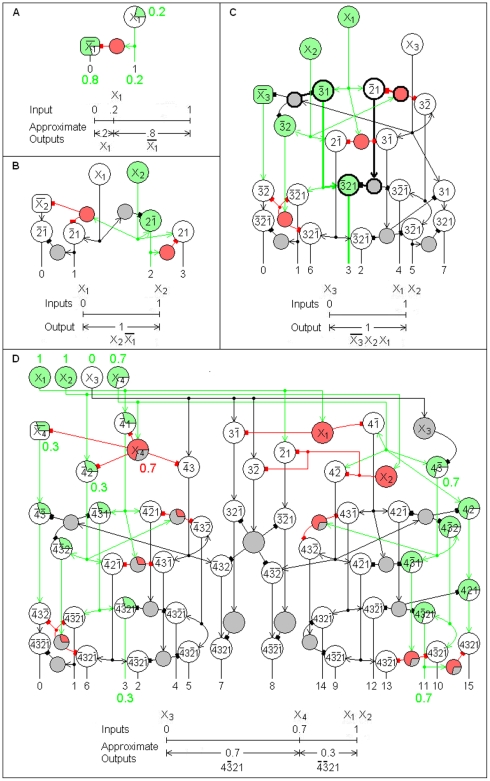
Recursive AND NOT Conjunctions.A Recursive AND NOT Conjunction (RANC) is a general logic circuit that produces conjunctions, with negations, and is defined recursively in terms of AND NOT gates. An n-RANC produces conjunctions of n propositions. A Complete n-RANC produces all conjunctions corresponding to the 2n possible combinations of truth values of n propositions. Examples of Complete n-RANCs are shown here for n = 1–4. The label on each neuron represents its response. The maximum and minimum possible responses 1 and 0 can stand for the logical values true and false, making the network outputs logical functions of the inputs. Arrows indicate excitatory input; blocks indicate inhibitory input. Spontaneously active neurons are square. To illustrate example inputs and outputs, active neurons are colored. Inactive inhibitory cells are shaded. The line graphs below each circuit diagram illustrate the RANC interval measure property and the Boolean and fuzzy logic of the example inputs and outputs.